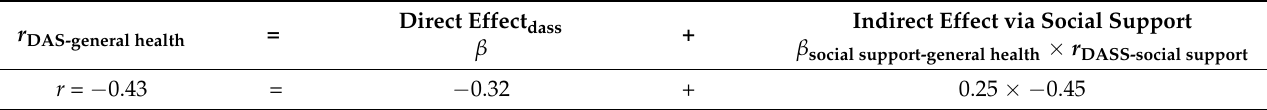
Table 5. Equation model to predict general health. Model 1.